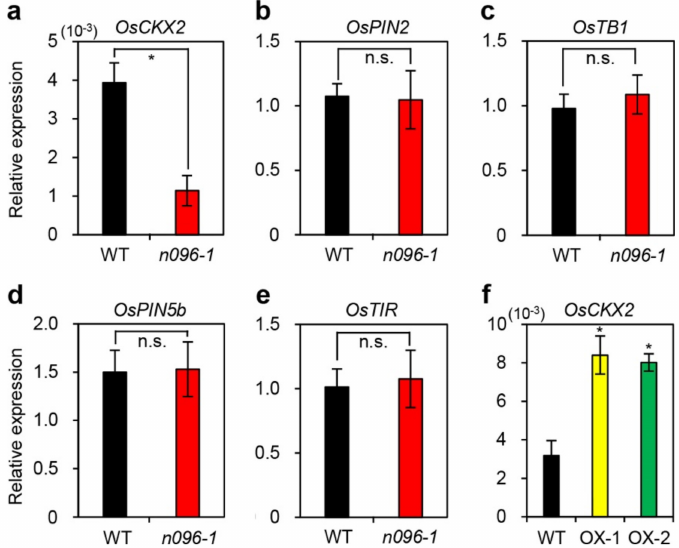
Figure 5. ONAC096 positively regulates OsCKX2 expression. Total RNA was isolated from the tiller bases of plants at the tillering stage. OsCKX2 ( a ), OsPIN2 ( b ), OsTB1 ( c ), OsPIN5b ( d ), and OsTIR ( e ) transcript levels were compared between the WT and onac096-1 ( n096-1 ). ( f ) Overexpression of ONAC096 upregulates the expression of OsCKX2 . The transcript levels of tillering-related genes were measured by RT-qPCR and normalized to that of OsUBQ5 . Relative expression was calculated using the ∆∆ C T method. Mean and SD values were obtained from three biological repeats. Asterisks indicate statistically significant di ff erences between onac096-1 ( a – e ) and ONAC096 -OX plants (OX-1 and OX-2) ( f ) compared to the WT, as determined by Student’s t -test (* p < 0.05; n.s., not significant). The experiments were repeated twice with similar